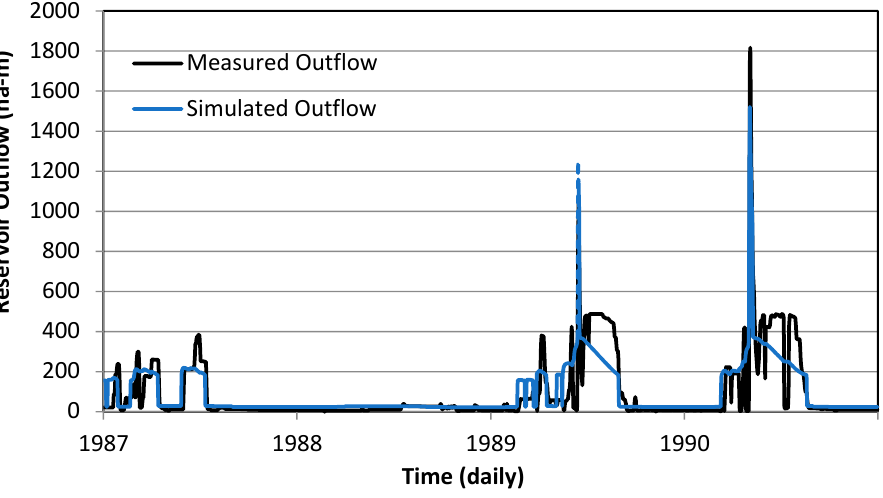
Figure 2. Measured and simulated daily reservoir releases for Grapevine Reservoir near Dallas, Texas.